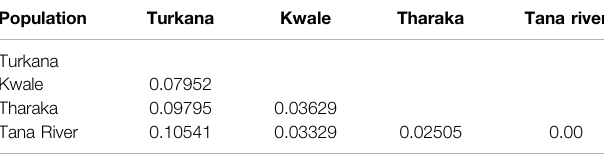
TABLE 3 | Pairwise F ST values of Kenyan populations of Hyphaene compressa .